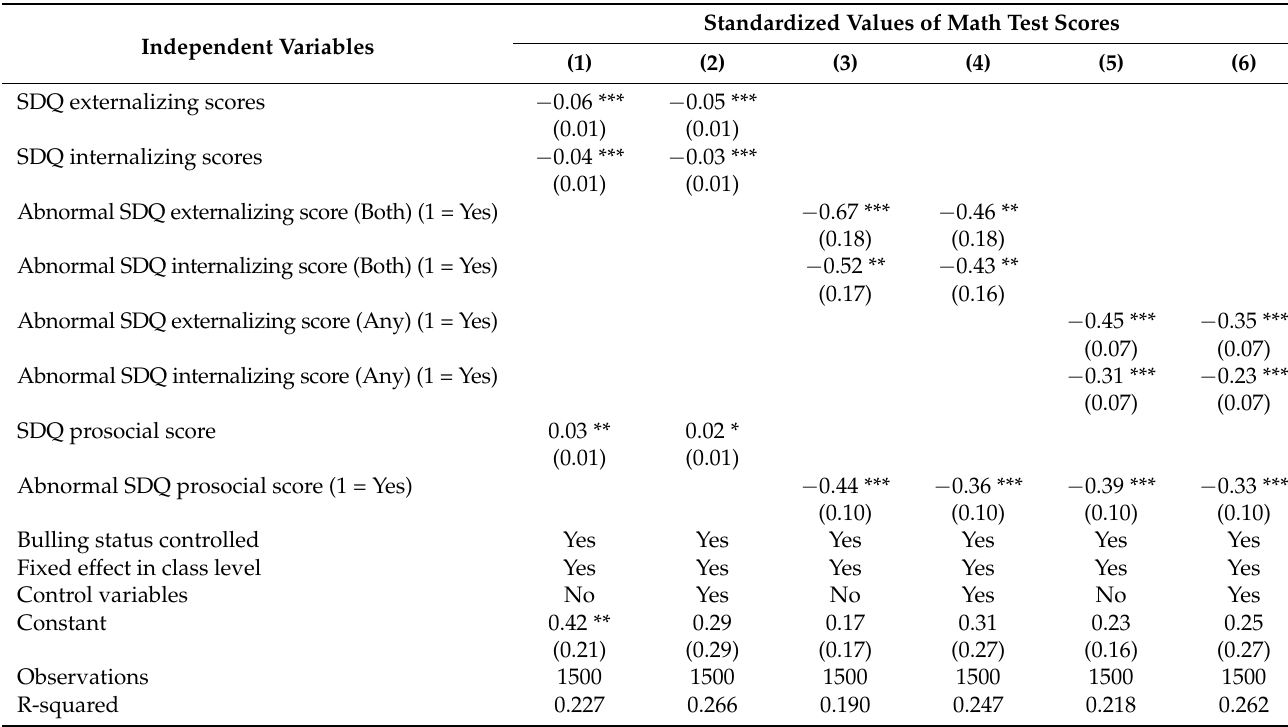
Table 5. OLS regression of SDQ score and academic performance in